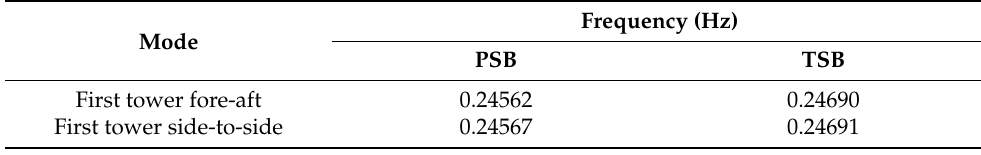
Table 7. First natural frequencies of SBs.